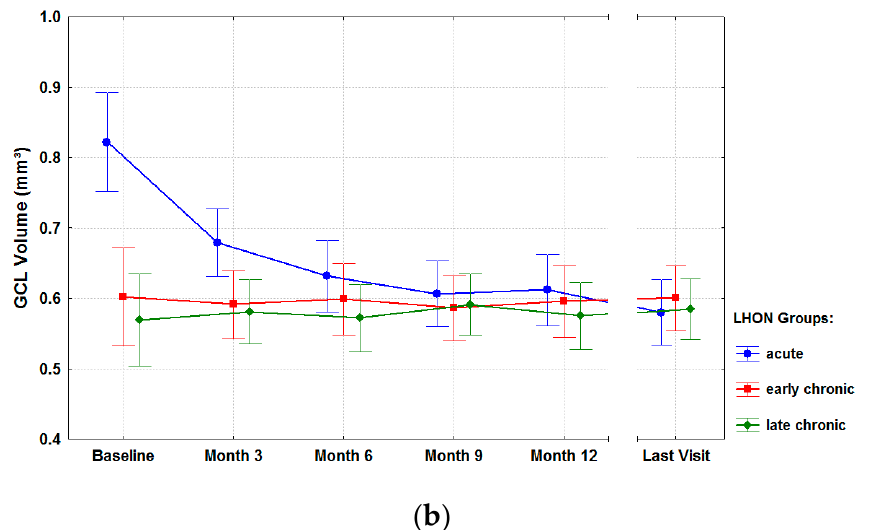
Figure 5. OCT measurements over time in the different groups of LHON patients treated with idebenone. Time from LHON onset at treatment initiation was <1 year in acute patients, 1–5 years in early chronic patients and >5 years in late chronic patients. ( a ) Peripapillary retinal nerve fiber layer (pRNFL) thickness. ( b ) Macular ganglion cell layer (GCL) volume. Data are presented as least square means and 0.95 confidence intervals.